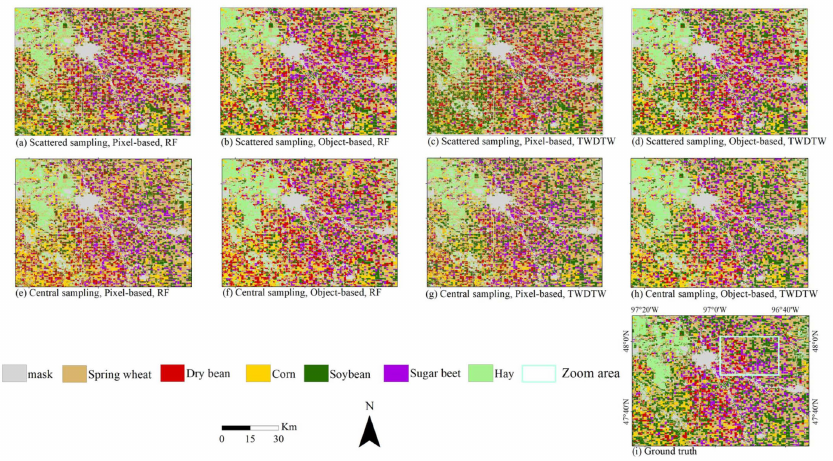
Figure 7. Crop classification results under different sampling strategies, perspectives, and classi- fiers. RF and TWDTW are the abbreviations of Random Forest and Time-Weighted Dynamic Time Warping,